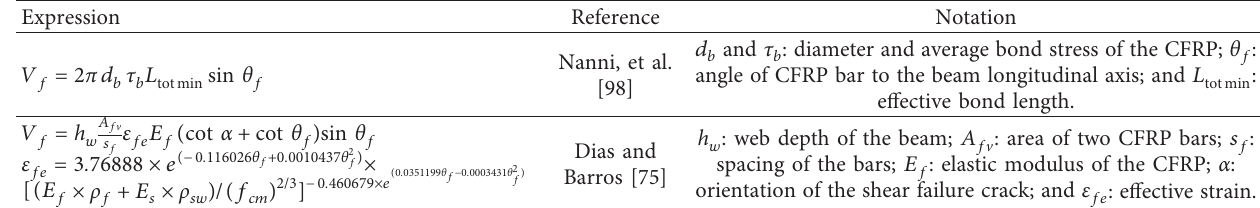
orientation of the shear failure crack; and ε fe : effective